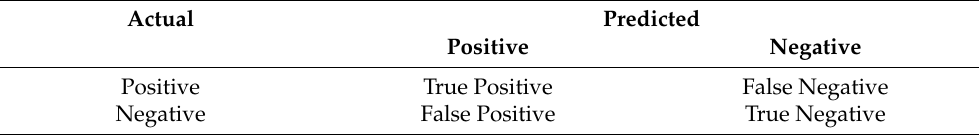
Table 1. The Confusion